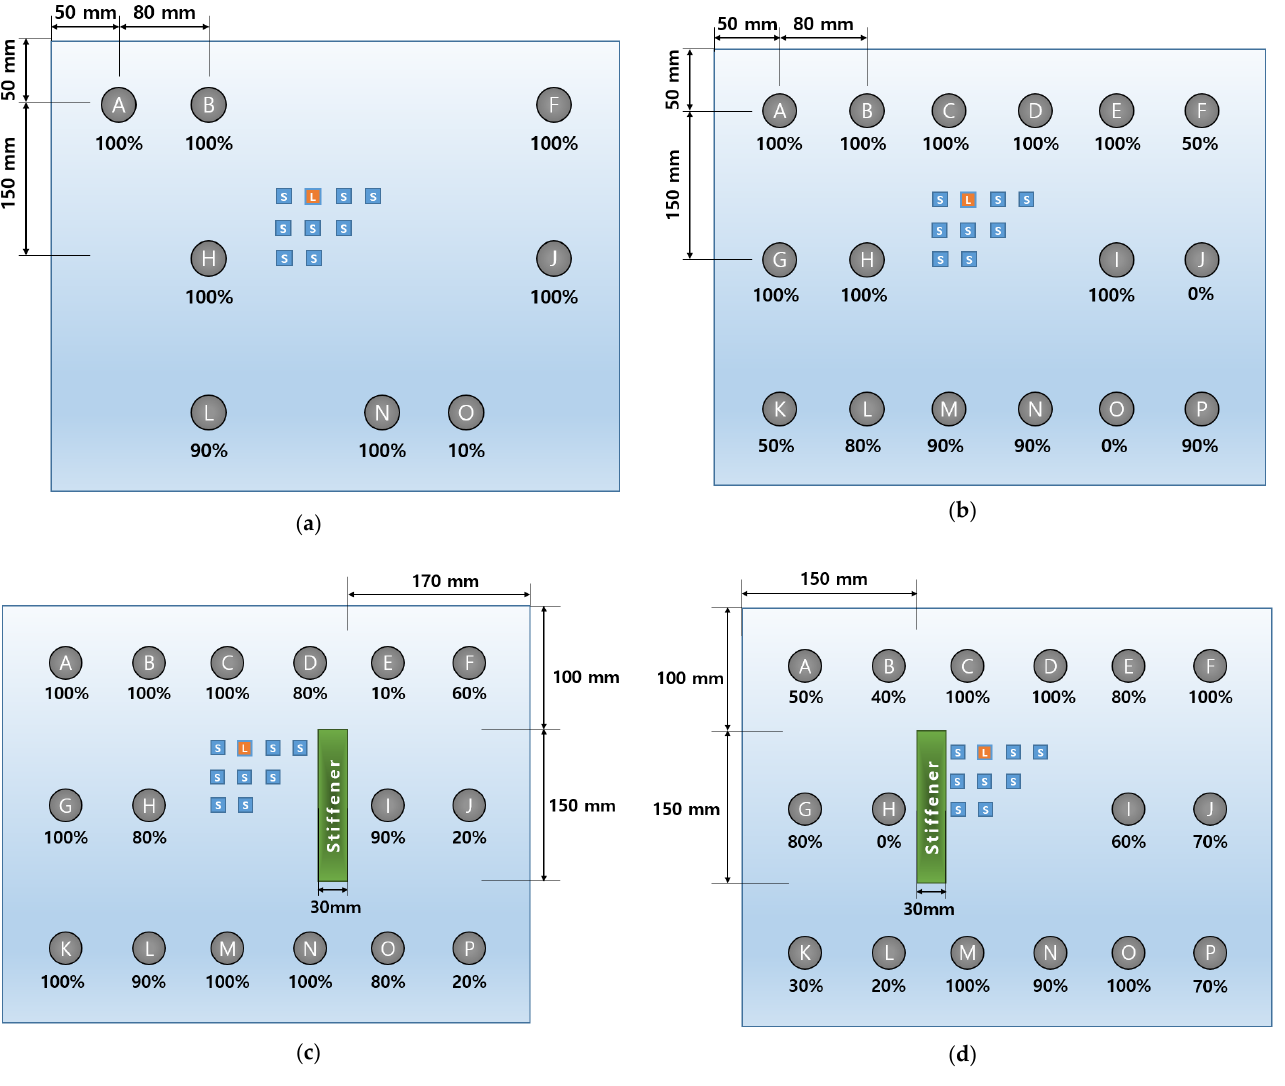
Figure 24. ( a ) Classification accuracy for randomly selected eight defect locations; ( b ) classification accuracy for 16 defect locations; ( c ) classification accuracy for attaching steel bar to right side of panel; ( d ) classification accuracy for attaching steel bar to left side of panel. Table 13. Averaged classification accuracy. Figure Number